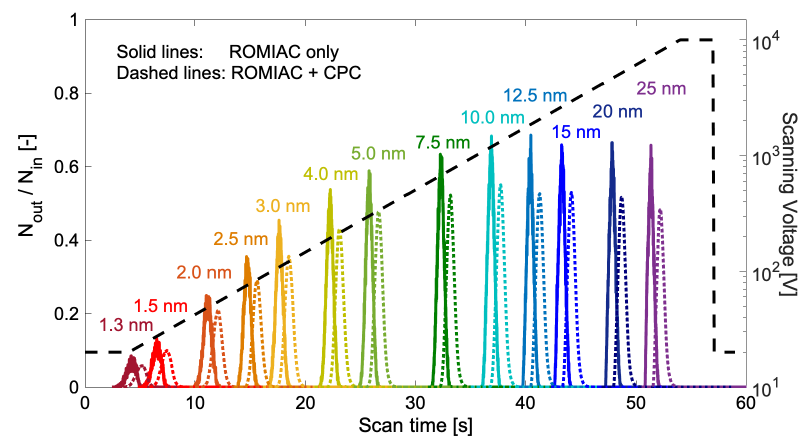
Figure 3. Simulated transfer function of the scanning ROMIAC with monodisperse input particles in the 1.3–25nm size range. The transfer function is calculated as the ratio of the particle number at the exit and the entrance of ROMIAC over a voltage scan (dashed black line) with t ramp = 50s. Solid lines show the transfer function of the classifier (scanning ROMIAC) only; dashed lines show the simulated ROMIAC transfer function coupled with the CPC residence time distribution (see Eq. 12). The integrated transfer function peaks (dashed lines) are used to compute the inversion kernel for nSEMS data